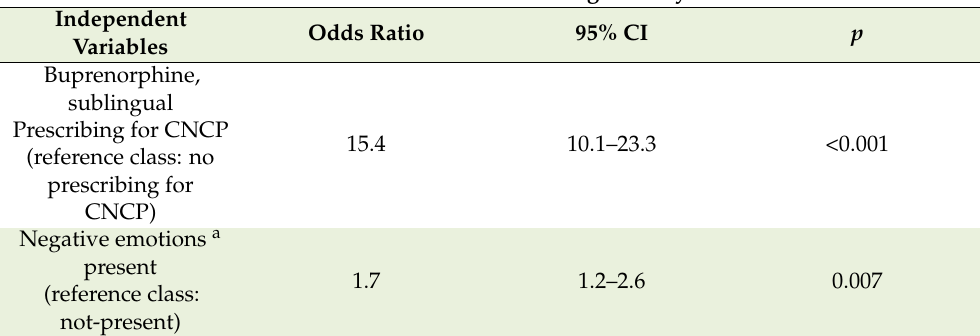
Table 5. Binary logistic regression analysis with non-guideline-compliant opioid prescribing (ultrafast- acting fentanyl for CNCP) as dependent